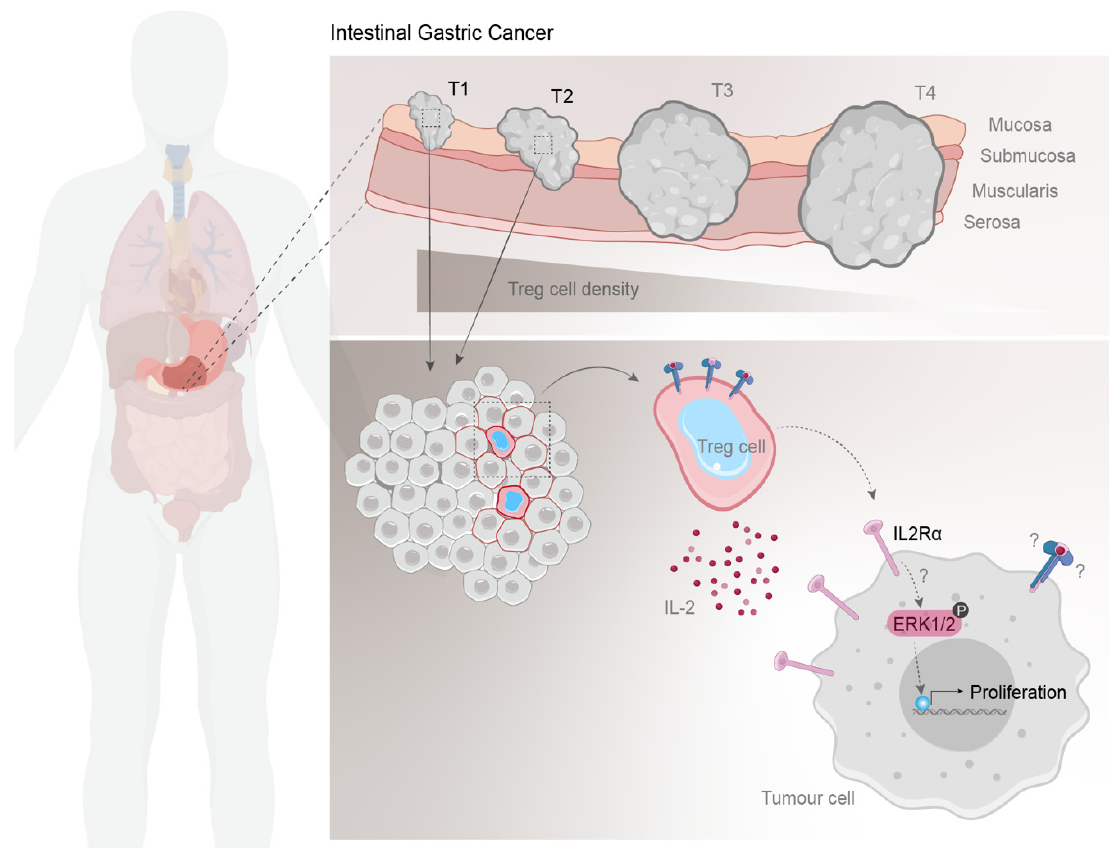
Figure 7. Schematic model of Treg prevalence in intestinal-type GC. Early-stage intestinal GC, that do not present vascular and perineural invasion, display higher density of Tregs. In vitro results indicate that Tregs might induce IL2R α expression at the membrane of tumor cells, which might associate with activation of MAPK signaling pathway, increased proliferation, and spheroid growth. Further studies are required to understand the mechanism behind IL2R α expression in tumor cells and its implications in future IO therapies.